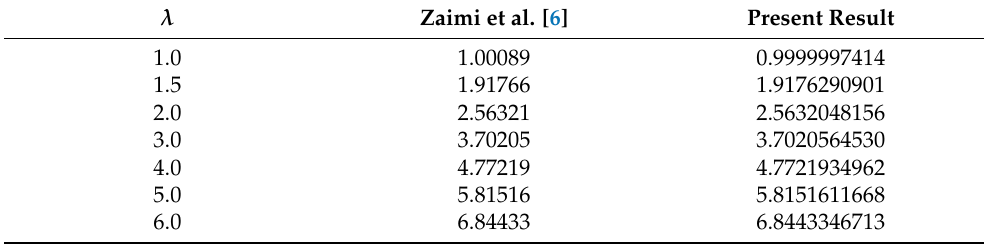
Table 7. Estimations for f (cid:48)(cid:48) ( 1 ) for λ with Zaimi et al. [6] by setting S = − 1.0, M = 0.0, φ s 1 = 0.0, φ s 2 = 0.0, Ec =